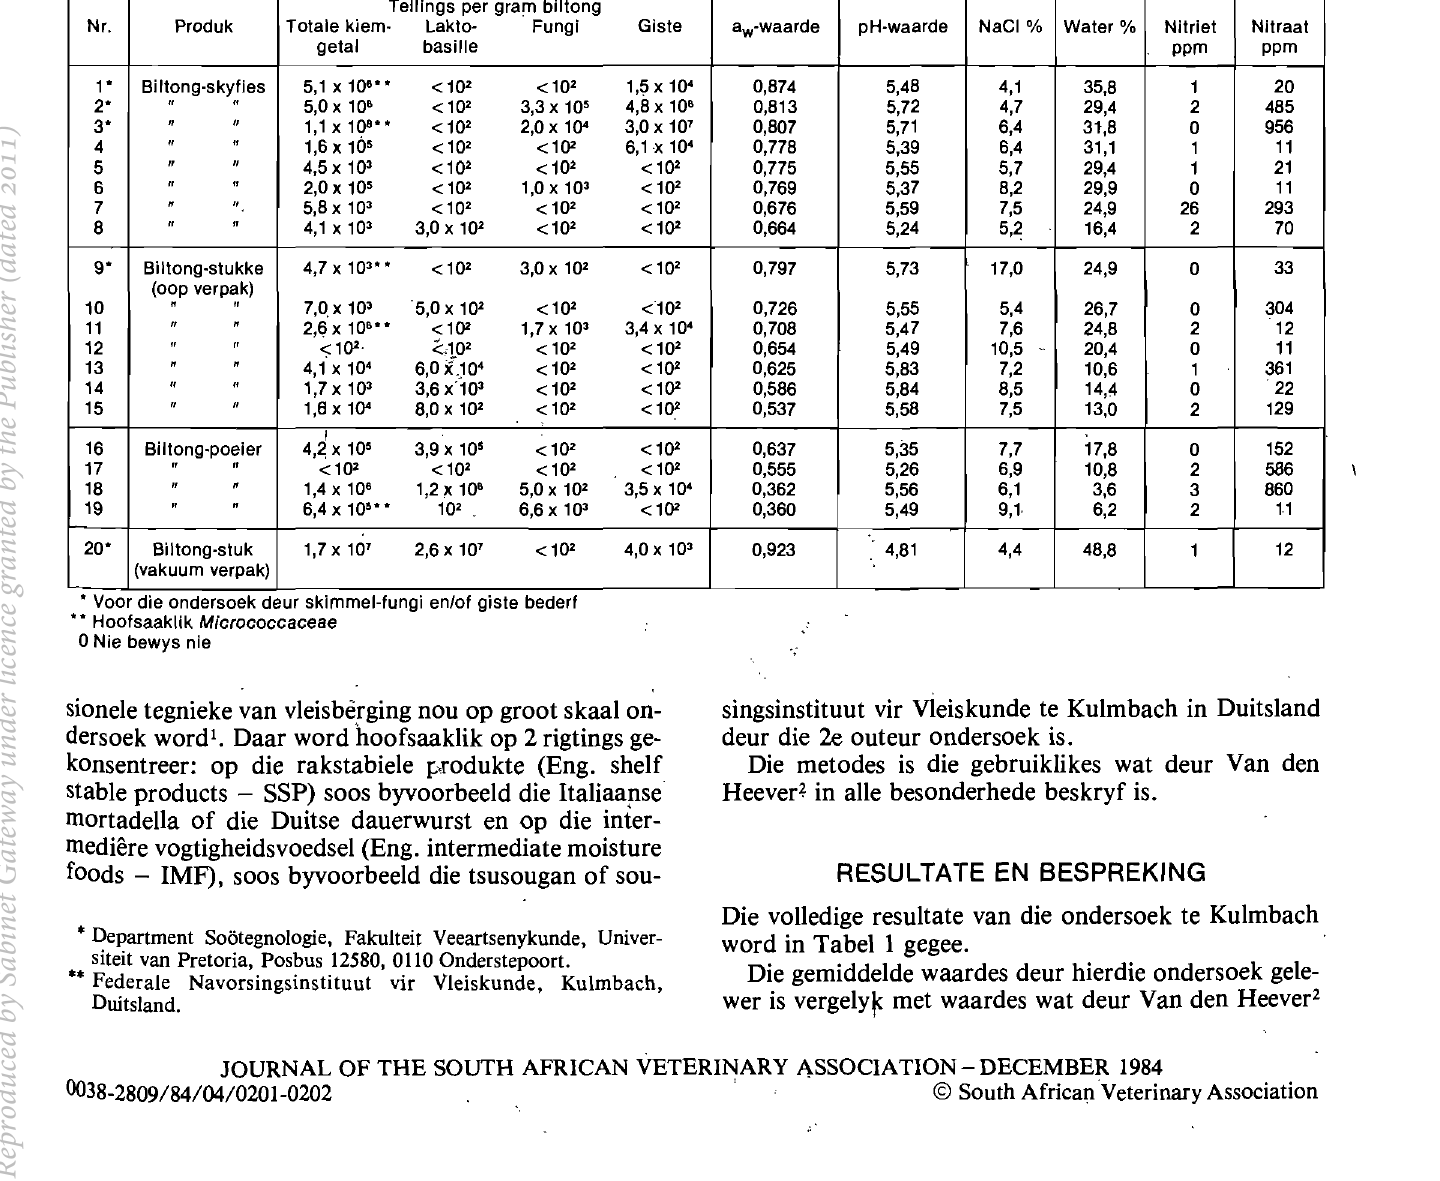
Tellings per gram biltong